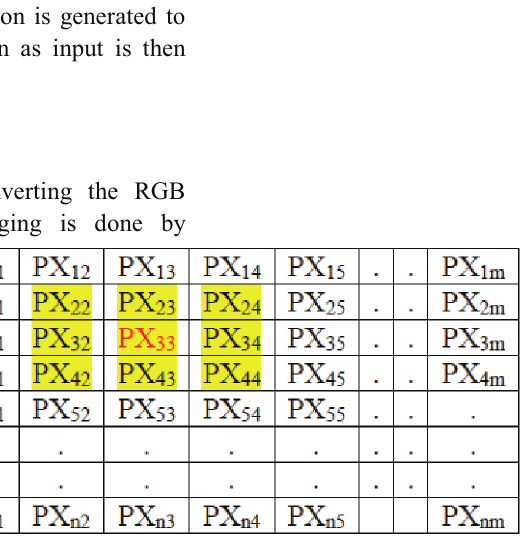
Fig.2 . merging of adjoining pixels